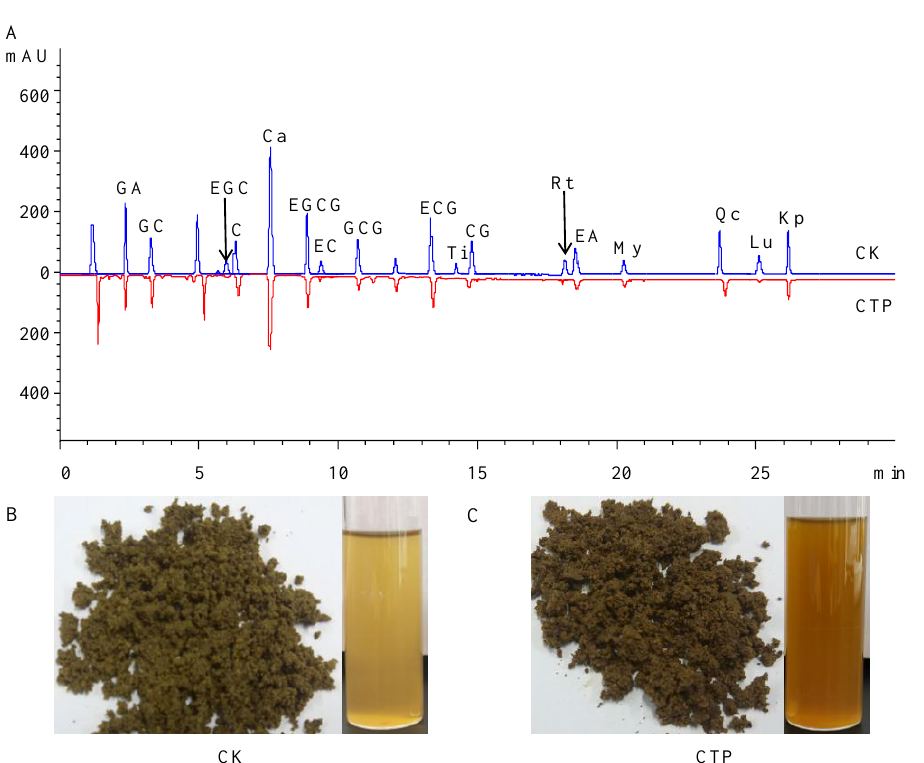
Figure 1. The catalysis of TPs in sun-dried green tea leaves using different concentrations ( A ) and with different reaction times of PPO ( B ). Different lowercase superscripts within a row indicated significantly different among comparisons ( p < 0.05).